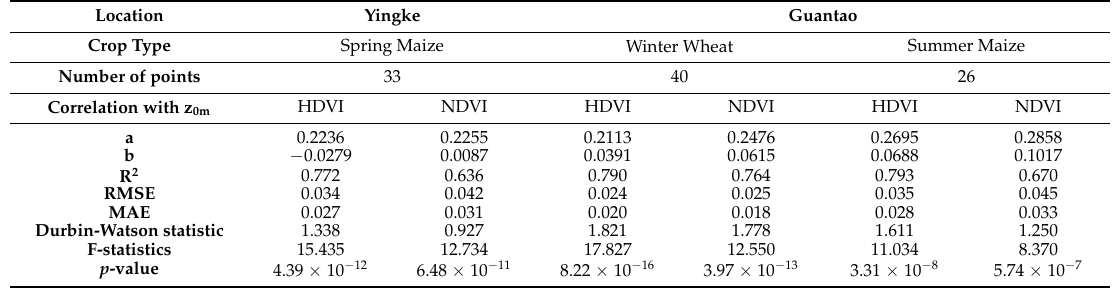
Table 4. The coefficients used to calculate z 0m for different crop types and statistical results. Location Yingke Guantao Spring Maize Winter Wheat Summer